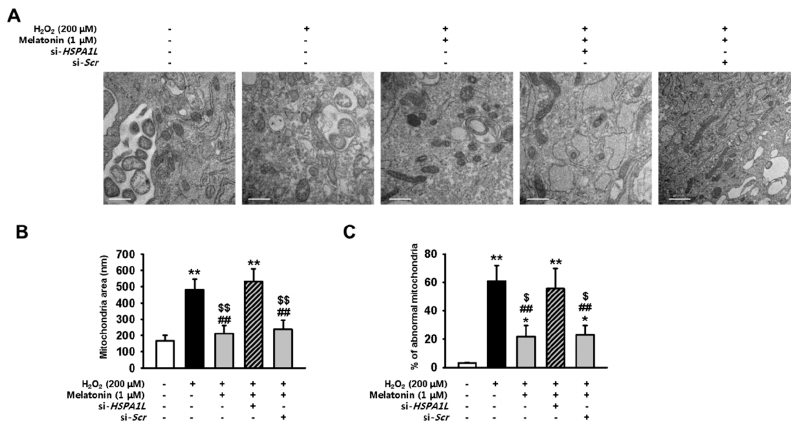
Figure 4. Melatonin increases the numbers of healthy mitochondria by stabilizing parkin in hMSCs subjected to oxidative stress. ( A ) Mitochondrial morphology was evaluated using TEM in hMSCs treated with melatonin (1 μ M, 24 h) and si- HSPA1L , and subjected to oxidative stress. Scale bar = 500 nm. ( B , C ) Quantitative analyses of morphometric data, and percentages of abnormal mitochondria showing swelling and severely disrupted cristae, as evaluated using TEM. Values represent the mean ± SEM. * p < 0.05, and ** p < 0.01 vs. untreated hMSCs; ## p < 0.01 vs. melatonin–treated hMSCs; $ p < 0.05, and $$ p < 0.01 vs. melatonin-treated hMSCs pretreated with si- HSPA1L .